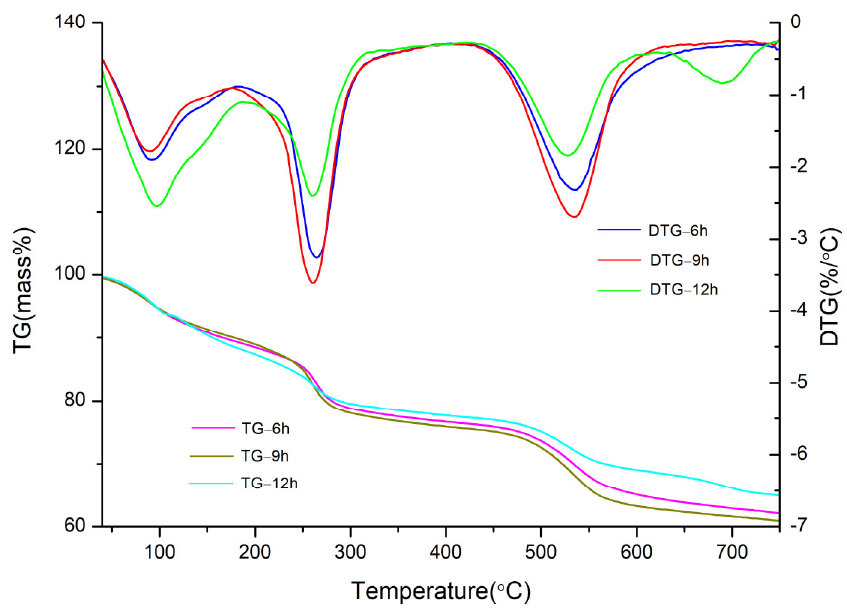
Figure 9. TG-DTG of CaAl–SiO 3 –LDHs samples prepared at different crystallisation time.